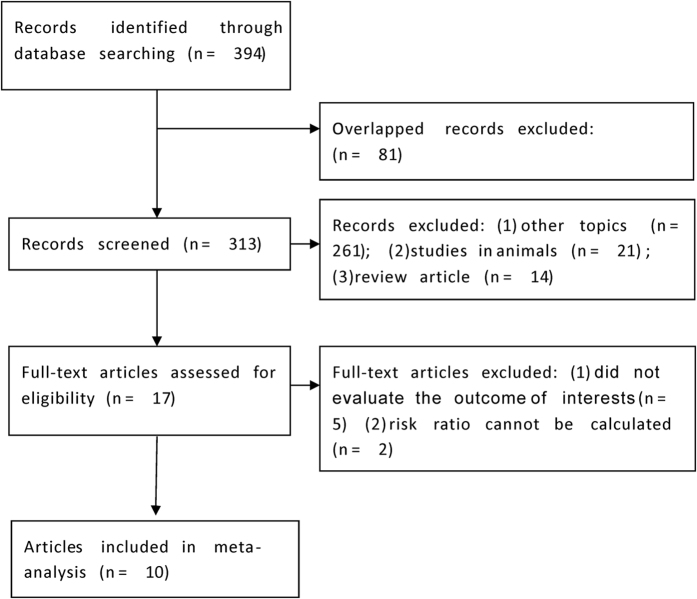
Flow diagram of included studies.